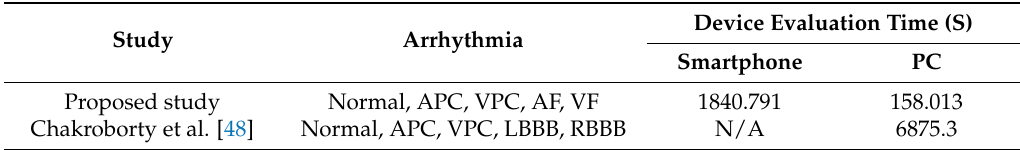
Table 7. The study evaluation time comparison in personal computer (PC) and smartphone for the MIT-BIH Arrhythmia database. (N/A = not available).